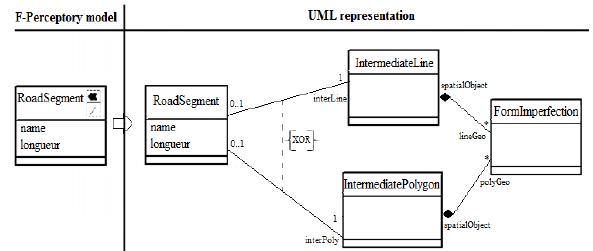
Figure 12. Fuzzy multiple geometry